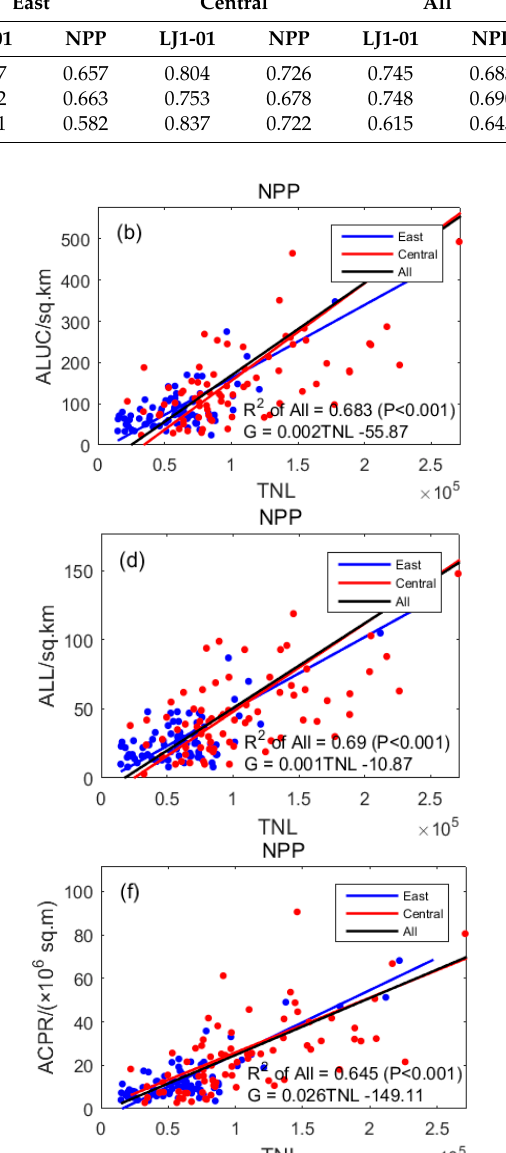
Table 7. Linear regression R 2 values for the area of land used and TNL.